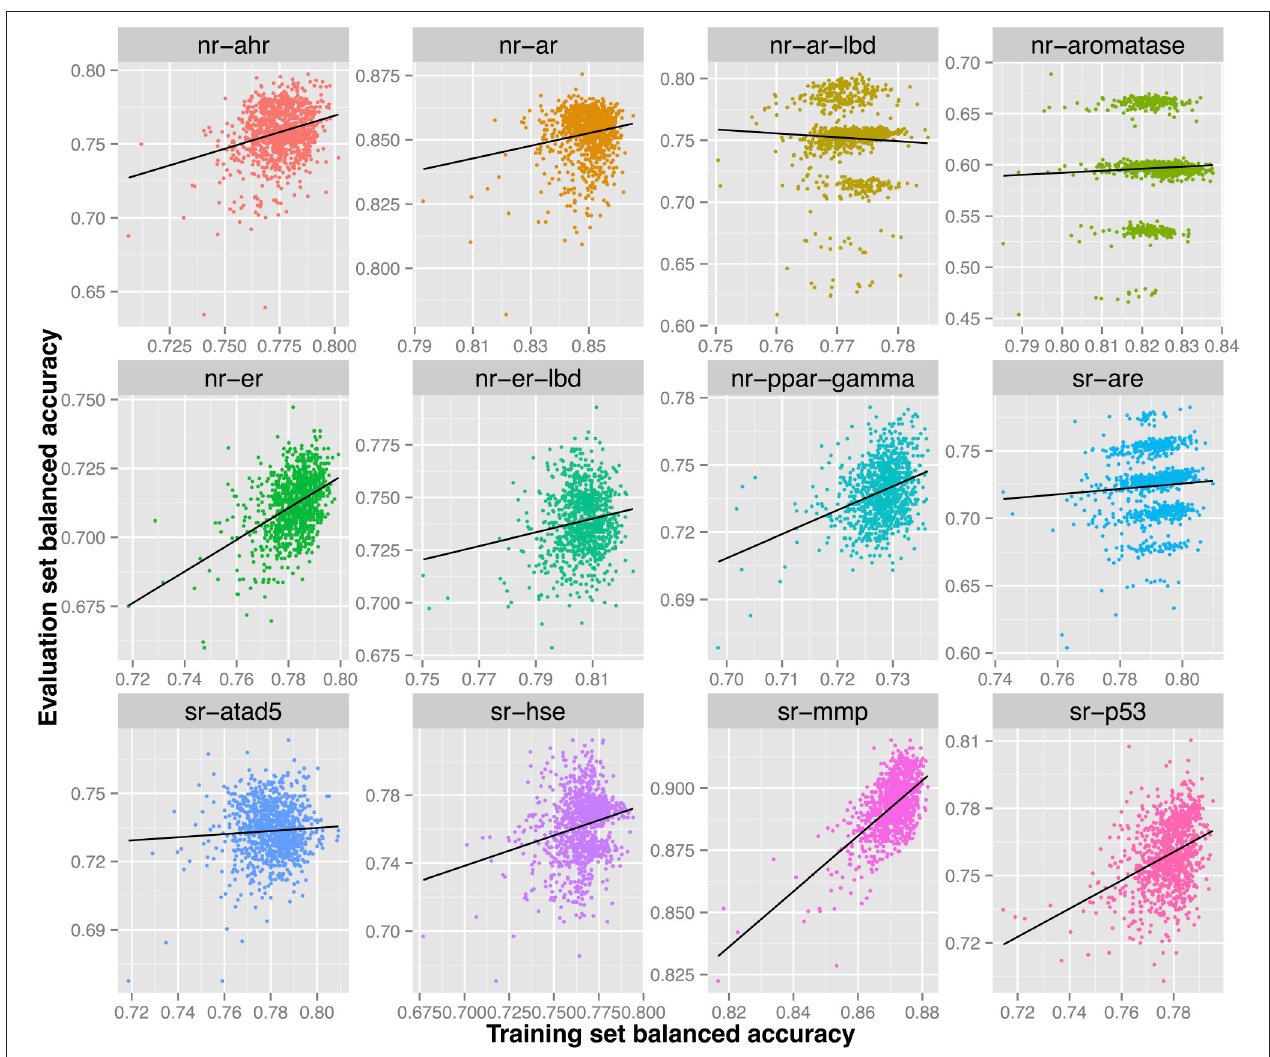
FIGURE 4 | Each sub-figure shows the performance of 1023 consensus models constructed for a single endpoint with x-axis representing the validated balanced accuracy on the training set and y-axis shows the balanced accuracy on the evaluation set. A positive trend line can be noticed with all endpoints except